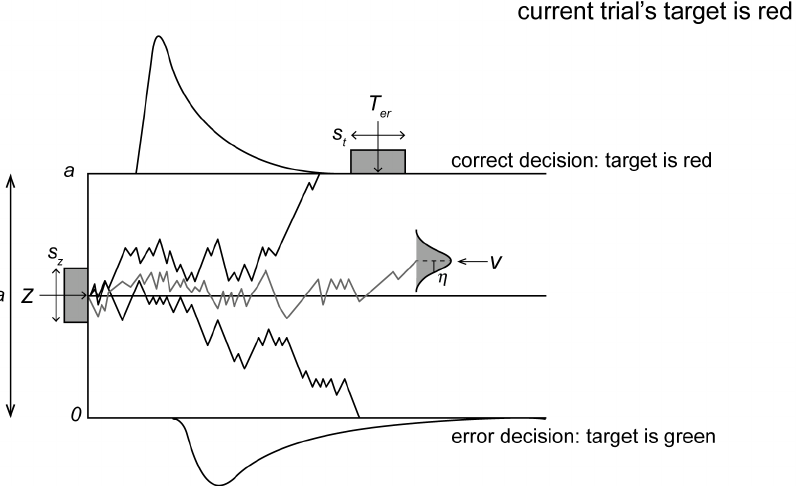
Figure 2. An Illustration of the Ratcliff Diffusion Model. Evidence starts accumulating at starting point z (inter-trial variation S z ). It accumulates with a drift rate mean of v and standard deviation of s (a scaling parameter not shown). The mean drift rate has an inter-trial variation of g . The evidence accumulates towards one of two decision thresholds, which are separated by the boundary separation a . An additional parameter is the non-decision time, T er (inter-trial variation S t ).